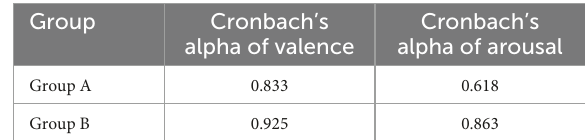
TABLE 3 Consistency of expert